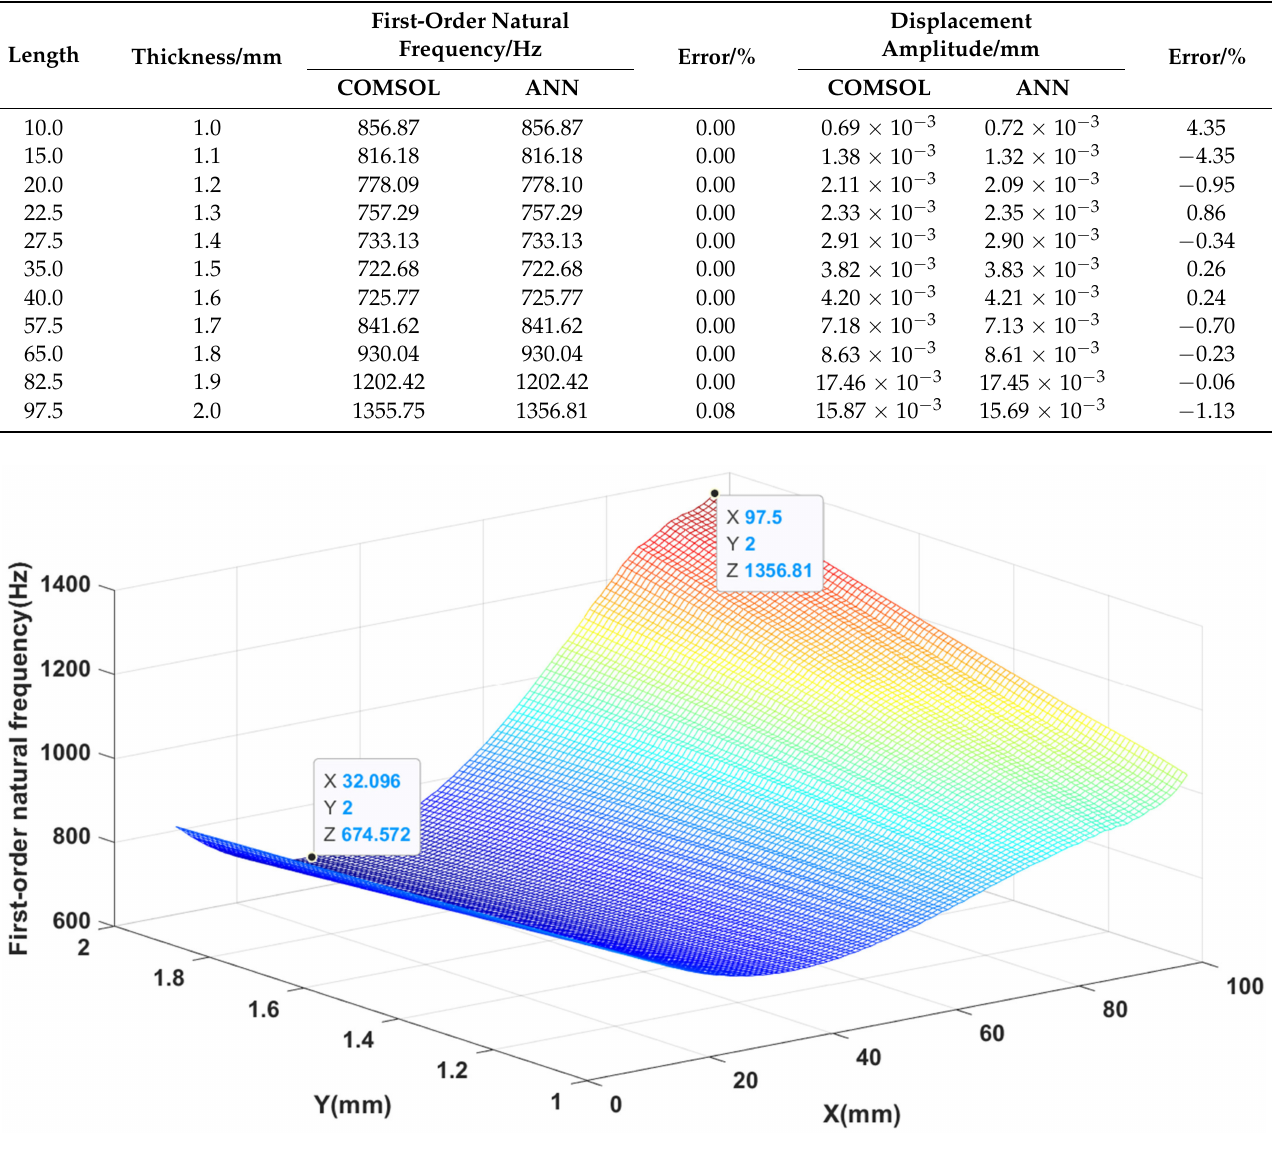
Table 3. Training and predicted results of 2-72-2 ANN model.